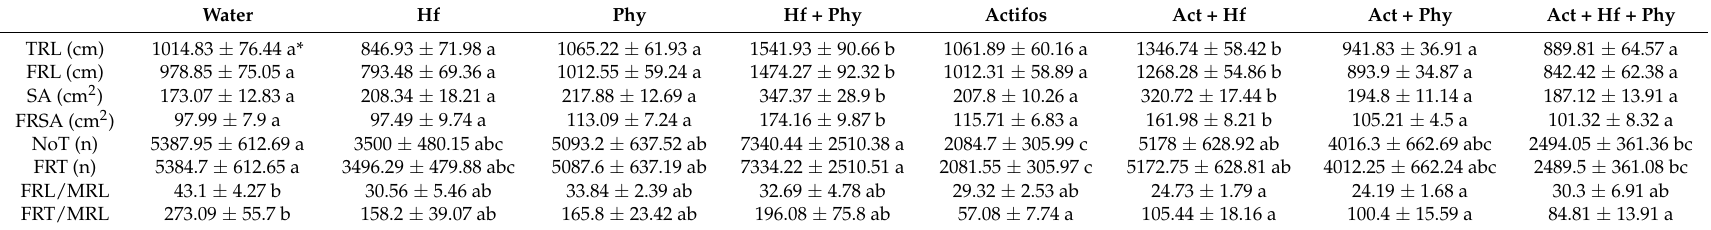
Table 3. Mean values and results of Tukey test for eight root morphology parameters of common ash seedlings observed in eight treatments.